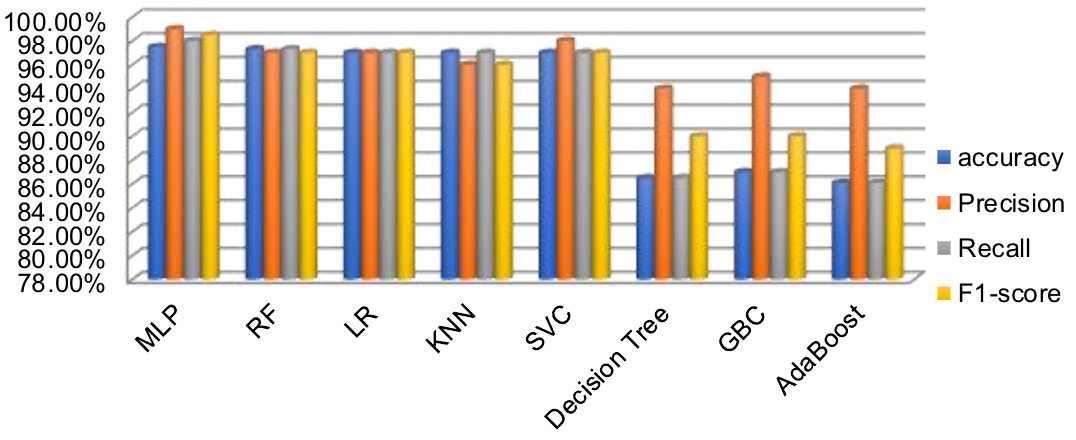
Fig. 6 Highest performance comparison of different classification algorithms on top 20